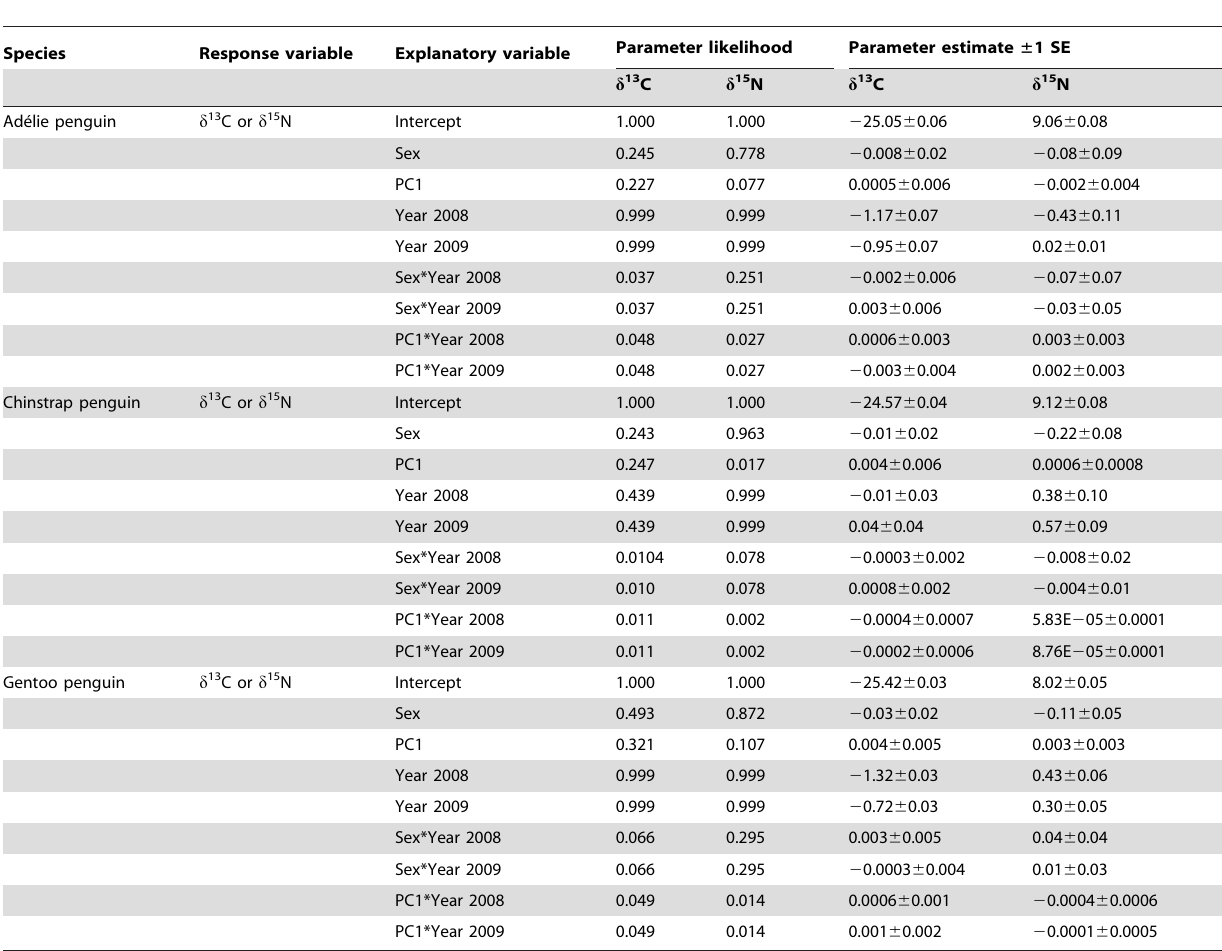
Table 4. Parameter estimates and likelihoods from candidate models for describing variation in foraging niche of Pygoscelis penguins assessed by d 13 C and d 15 N stable isotope